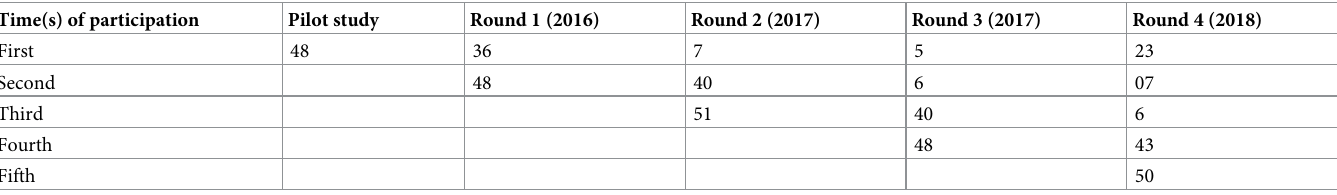
Table 3. Number of laboratories achieving satisfactory scores and their different participation